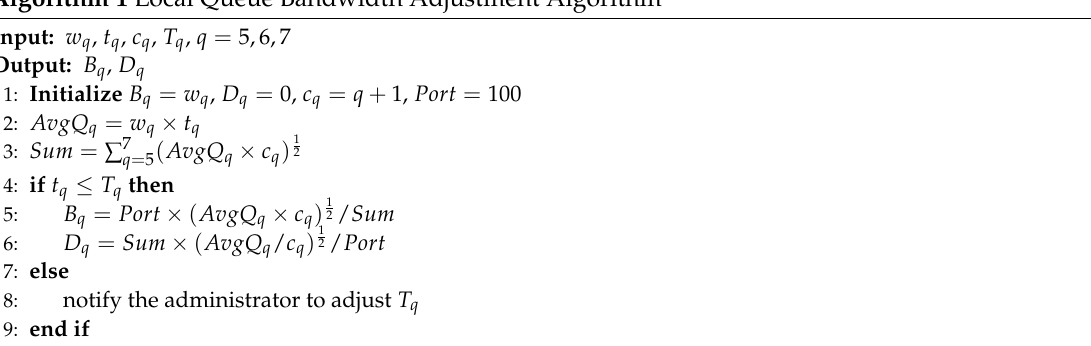
Algorithm 1 Local Queue Bandwidth Adjustment